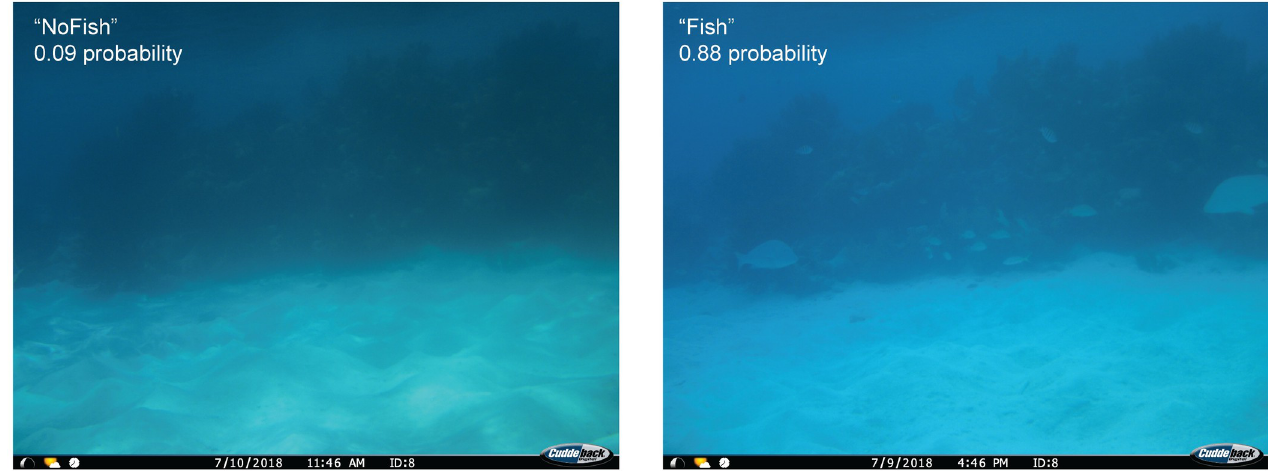
Fig 3. Empty (left) and fish-filled (right) images captured at the same camera site within 24 hours. The empty or “NoFish” photo was assigned only a 0.09 probability of containing a fish by our ResNet-50 model, whereas the model predicted a 0.88 probability of the second photo containing at least one fish, hence its “Fish” designation. Probabilities like these were used to sort images into “Fish” and “NoFish” categories to streamline further analysis. Reprinted from [39] under a CC BY license with